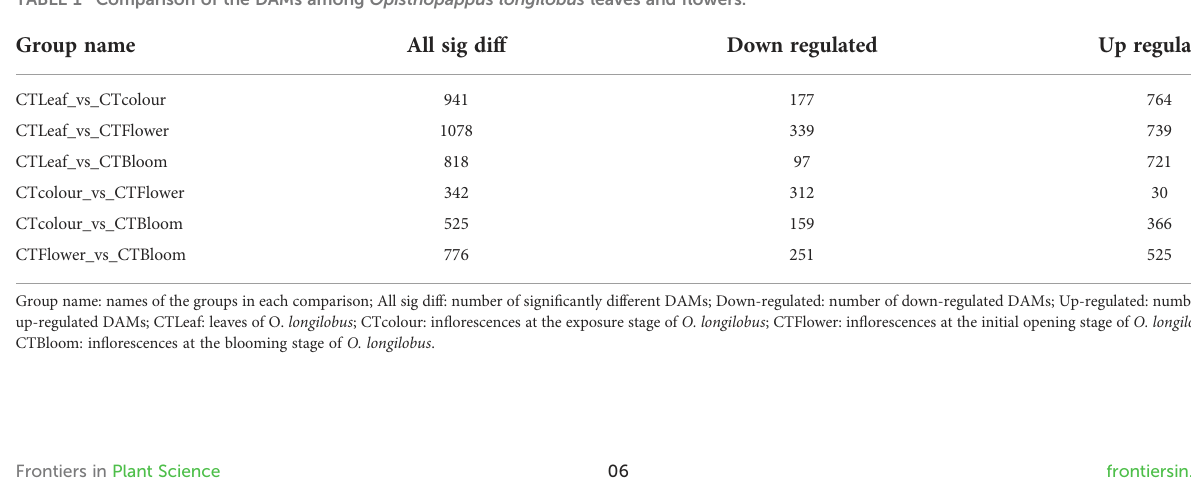
TABLE 1 Comparison of the DAMs among Opisthopappus longilobus leaves and fl